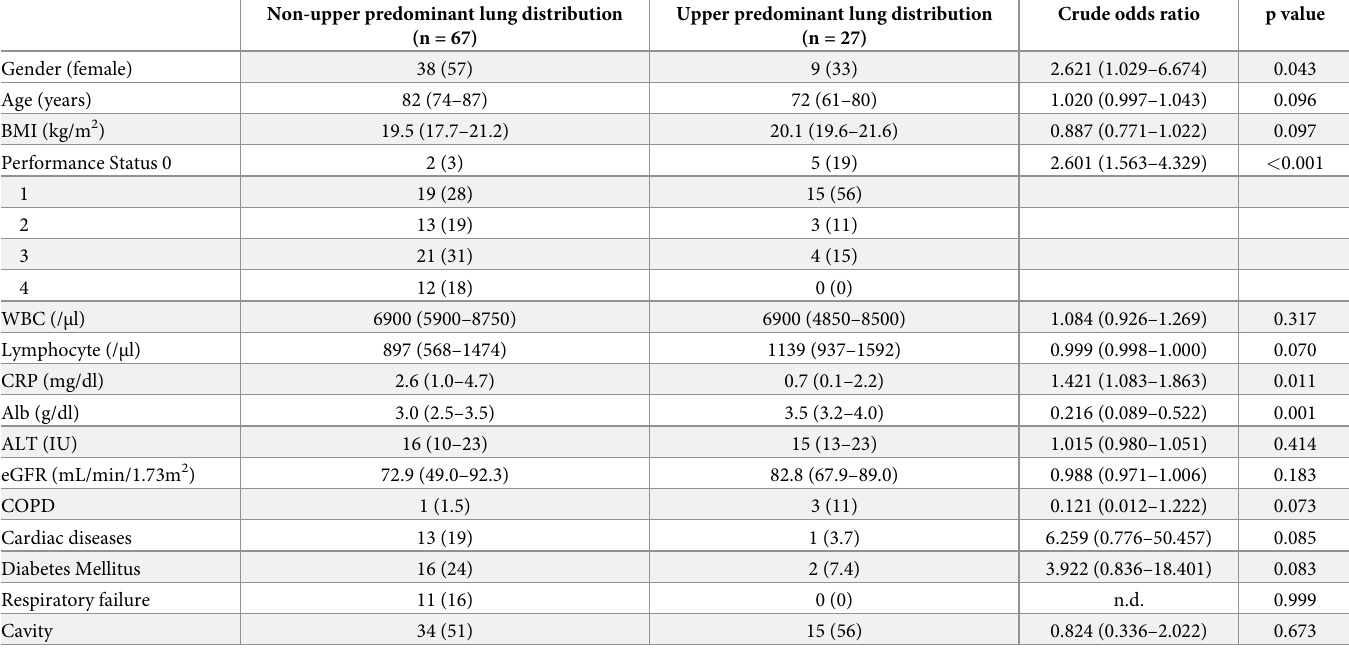
Table 3. Univariate logistic regression analysis of baseline characteristics associated with non-upper predominant lung distribution.